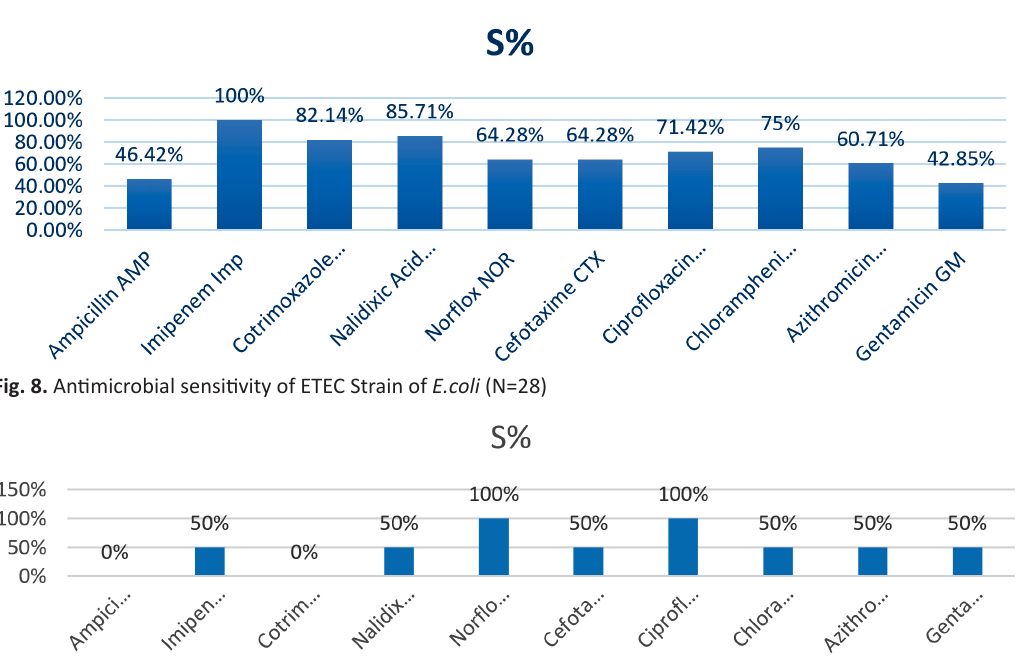
Fig. 9. Antimicrobial sensitivity of 2 EHEC